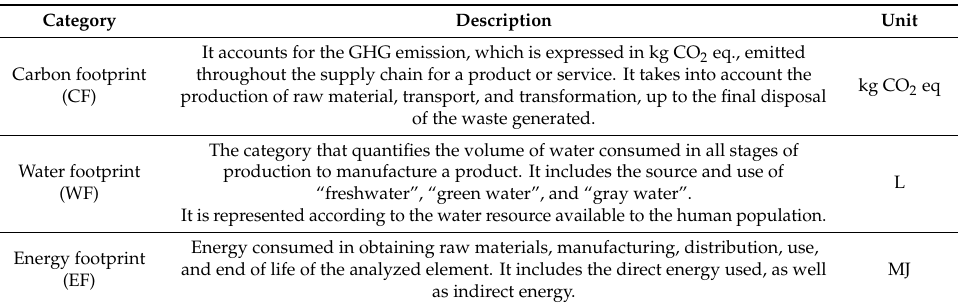
Table 1. List of impact categories